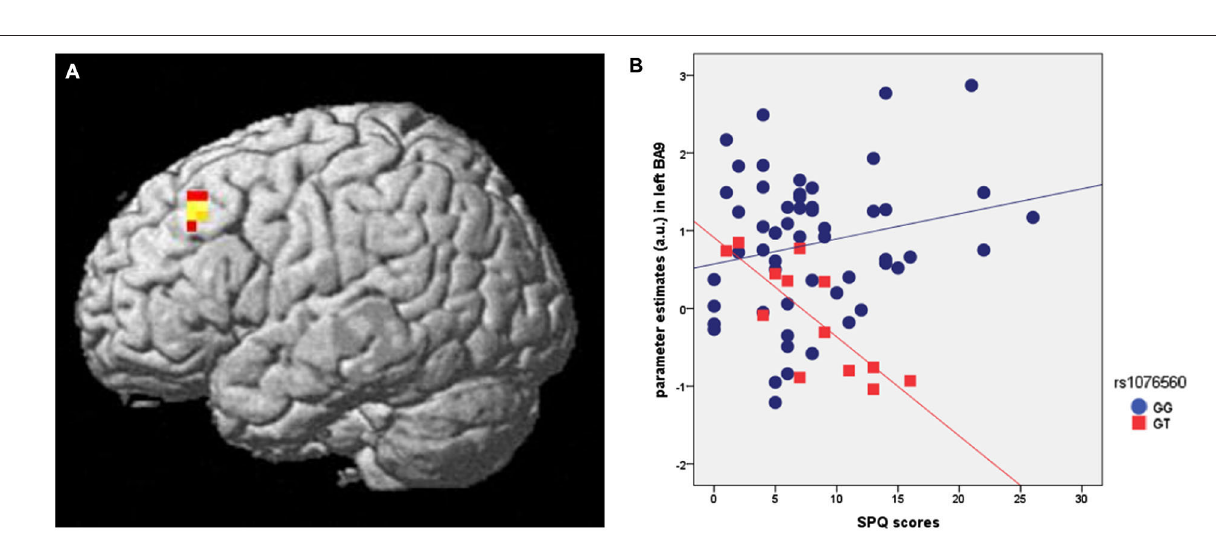
FIGURE 2 | (A) Rendered image of the brain showing the interaction between rs1076560 and SPQ scores on fMRI response during attentional control in left BA9 ( x : − 44, y :27, z :40). (B) Parameter estimates extracted from the cluster in BA9 cluster illustrated in (A)